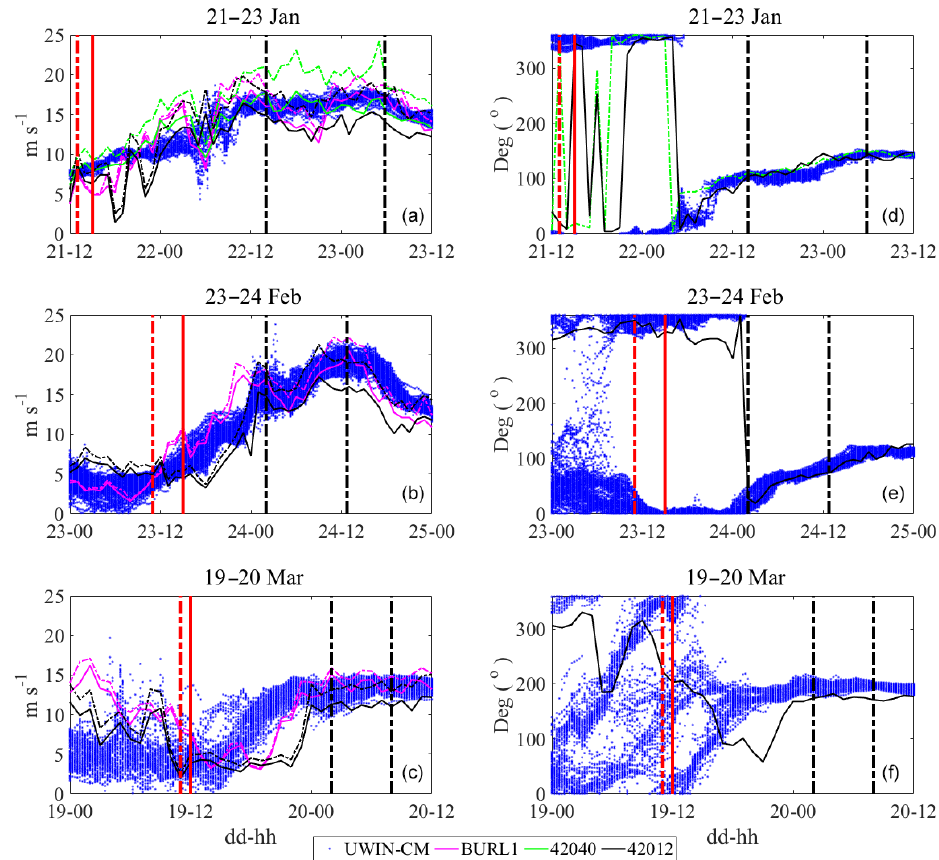
Figure 3. Wind velocity magnitudes (a, b, c) and directions (d, e, f) during the hours preceding, and including, each high wind event. Dashed vertical black lines show the beginning and end of the high wind analysis periods. Dashed (solid) red lines indicate beginning of the hour over which the pre-existing regional circulation was estimated with undrogued (drogued) drifters. U 10 wind data from the UWIN-CM are plotted at the nearest point to every drifter location. Wind observations from NDBC buoys BURL1, 42040 and 42012 are plotted as well. Solid lines show sustained winds, while dashed lines show wind gusts. All wind directions are plotted as the direction in which the wind is traveling. Buoy 42040 was only operational during the first wind event and BURL1 did not record any wind direction data during the